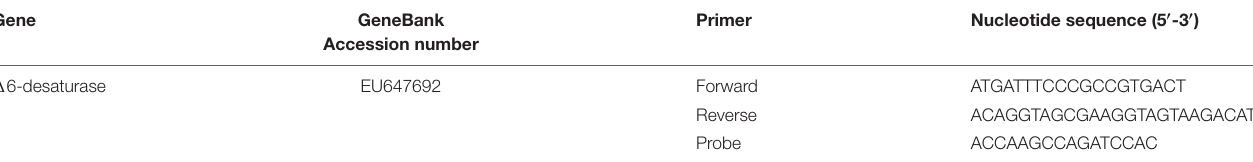
TABLE 4 | Primers and probe sequences used for the real time PCR quantification of (cid:49) 6-desaturase (or fads2 ) gene transcripts.